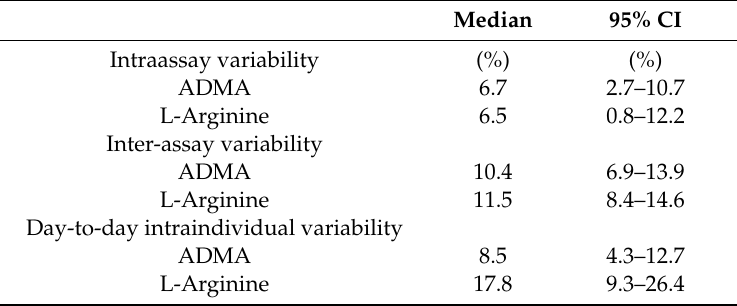
Table 1. Variabilities of the ADMA and L-arginine dried blood spot